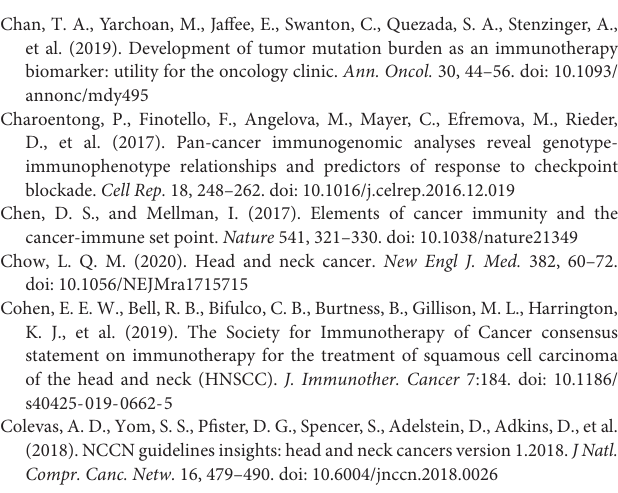
Supplementary Figure 1 | Genetic alternations of CMGs in HNSCC. Supplementary Figure 2 | Estimation of tumor-infiltrating lymphocytes in HNSCC. Supplementary Figure 3 | Clinical significance of TNFRSF12A and its correlation with chemokine genes. Clinical significance of TNFRSF12A was validated via GEPIA (A) and HPA (B) . (C) Representative images of immunohistochemistry of TNFRSF12A in HNSCC tissues via HPA (Scale bar = 200 µ m). (D) Volcano plot exhibited correlation between TNFRSF12A and chemokines in HNSCC tissues by Spearman